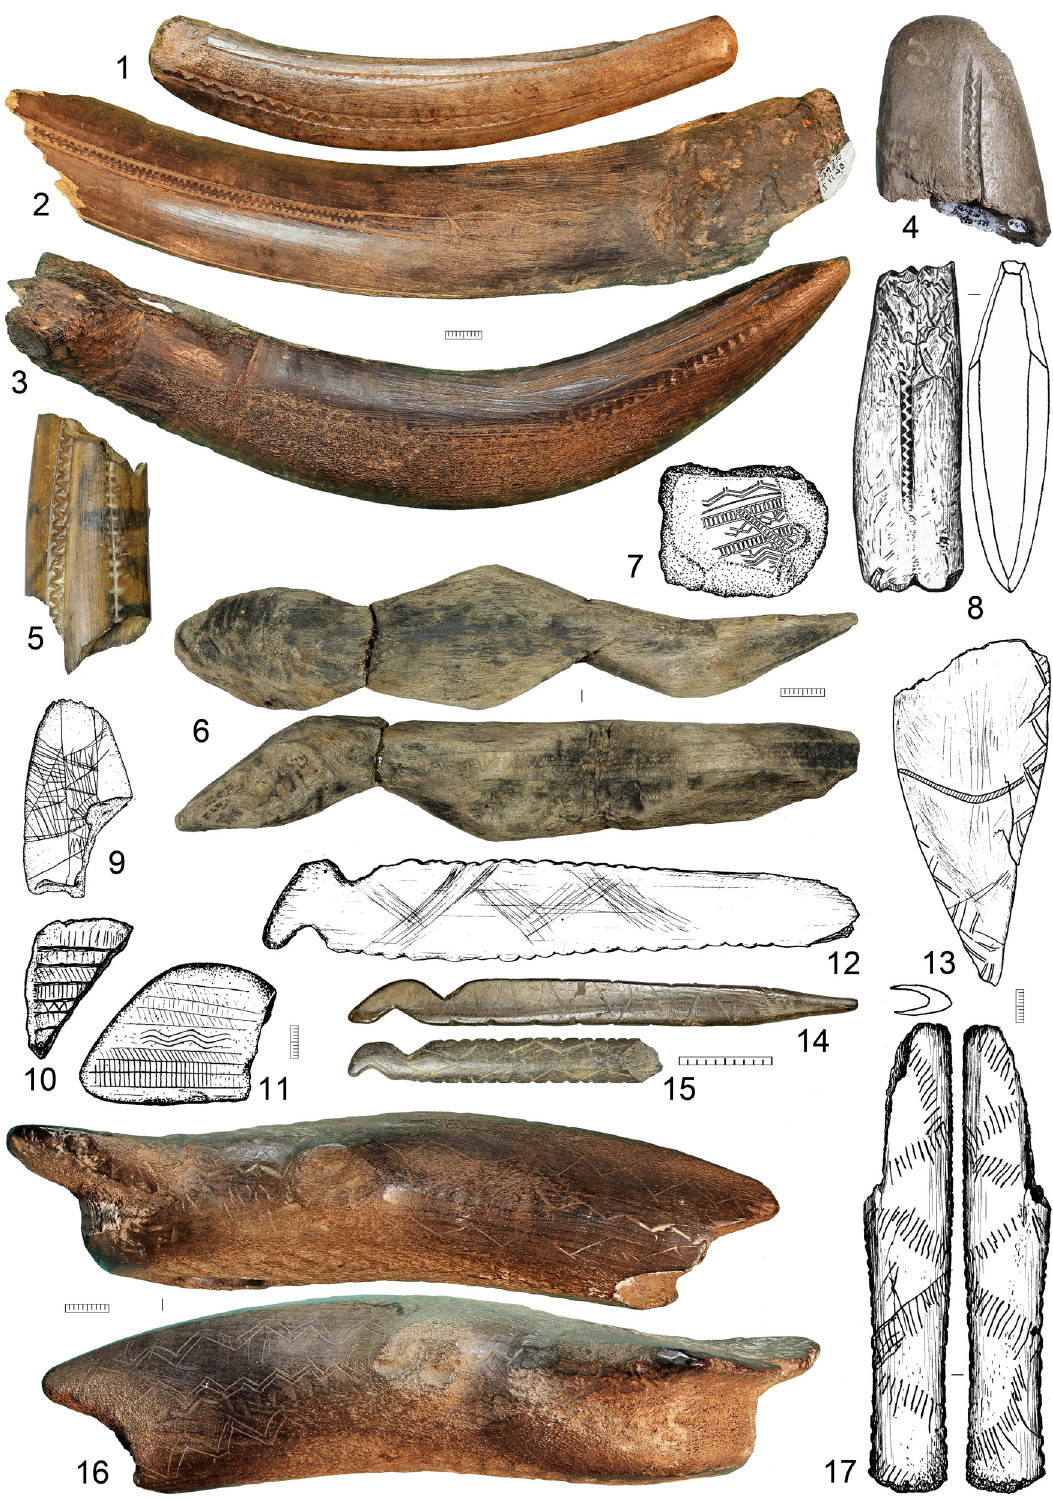
Figure 7: Zamostje 2 ( 1 – 7, 9 – 17 ) , Ivanovskoye II ( 8 ) . ( 1 – 4 ) sickle - shaped tools; ( 5 ) slotted dagger; ( 6 ) wooden snake fi gurine; ( 7, 9 – 11 ) engraved pebbles; ( 12, 14 – 15 ) snake - shaped knives and pins; ( 13 ) spoon; ( 16 ) ornamented elk head ( side views ) ; ( 17 ) handle. Late Mesolithic ( 2, 4 – 7, 9, 12 – 17 ) Early Neolithic – 11; unde fi ned – 1, 3, 8, 10. Figures 7, 9 – 13 by V. Lozovski, 17 – by D. Cherevko ( 8 – after Kostyleva & Utkin, 2010, Figure 13: 11 )